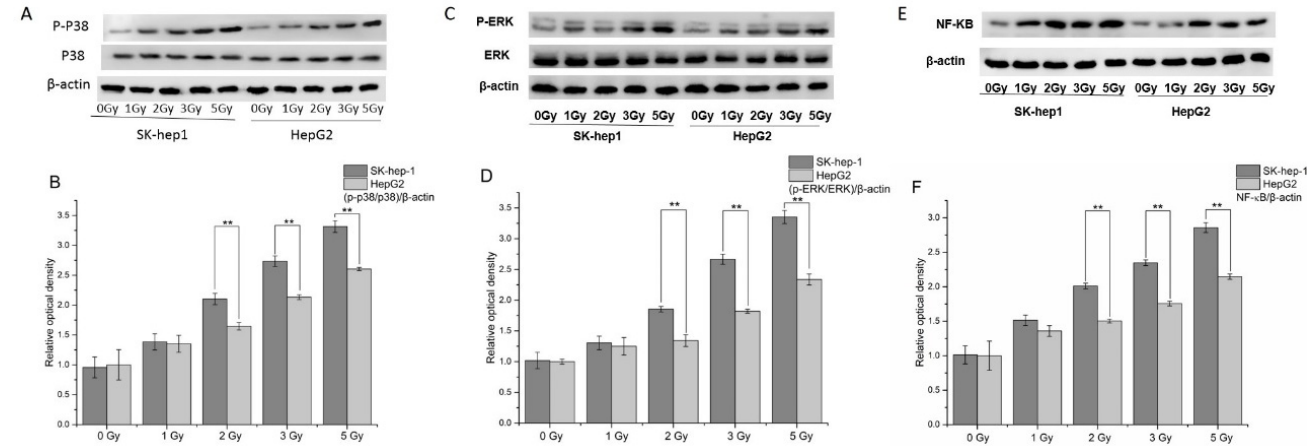
Figure 4. The expression of the MAPK and NF- κ B signaling pathways proteins in HepG2 and SK- hep-1 cells after X-ray irradiation. ( A ) The expression of p-p38 and p38 in HepG2 and SK-hep-1 cells 6 h after X-ray irradiation. ( B ) Quantification of p-p38/p38 expression in HepG2 and SK-hep-1 cells 6 h after X-ray irradiation. ( C ) The expression of p-ERK and ERK in HepG2 and SK-hep-1 cells 6 h after X-ray irradiation. ( D ) Quantification of p-ERK/ERK expression in HepG2 and SK-hep-1 cells 6 h after X-ray irradiation. ( E ) The expression of NF- κ B in HepG2 and SK-hep-1 cells 6 h after X-ray irradiation. ( F ) Quantification of NF- κ B expression in HepG2 and SK-hep-1 cells 6 h after X-ray irradiation. ** p < 0.01 compared between the two cells.